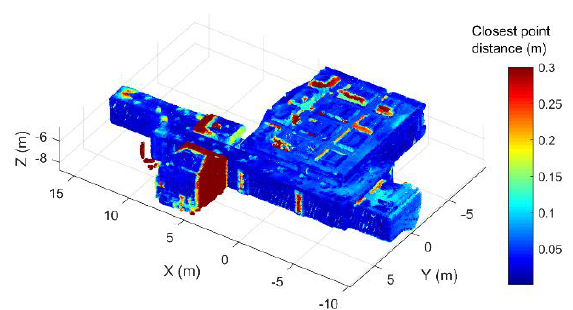
Figure 7. Closest point distances between the Hololens and the laser scanner point cloud.